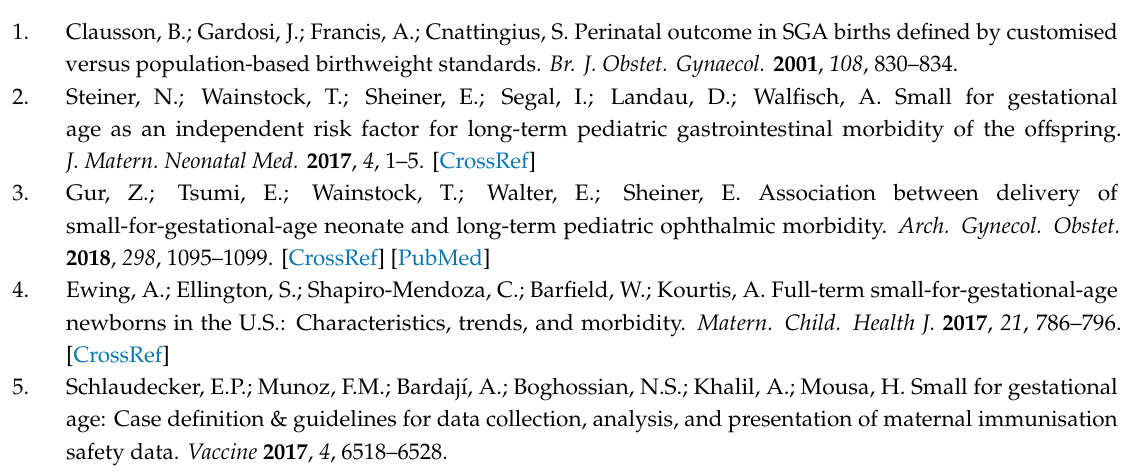
Table S1: neurological morbidity ICD-9